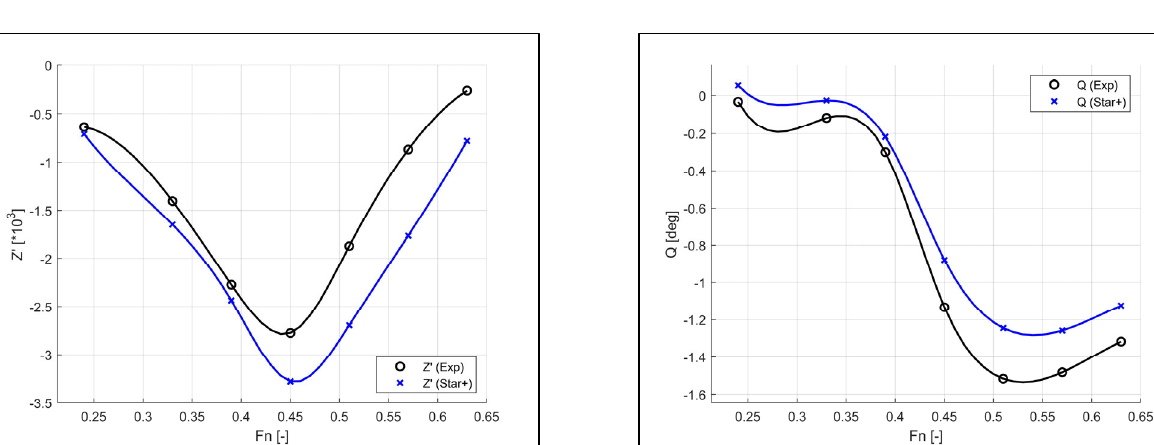
Figure 6. Numerical total ( left ) and residual ( right ) resistance values compared to the experiments.